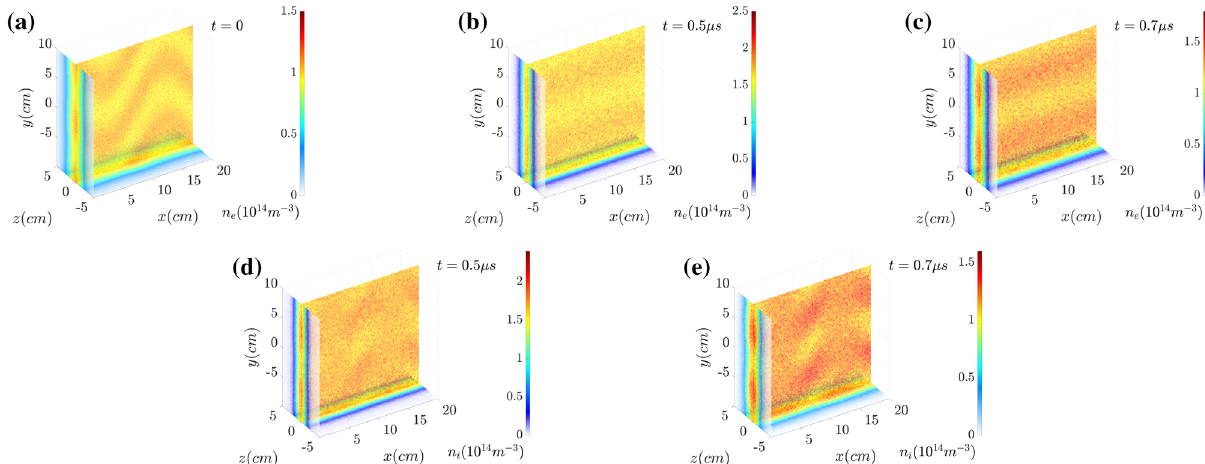
Figure 7. Electron number density n e at ( a ) t = 0.0 , ( b ) t = 0.5 µ s and ( c ) t = 0.7 µ s , and the proton density n i at ( d ) t = 0.5 µ s and ( e ) t = 0.7 µ s . In this figure the filamentation does not grow well compared with the results in Fig.